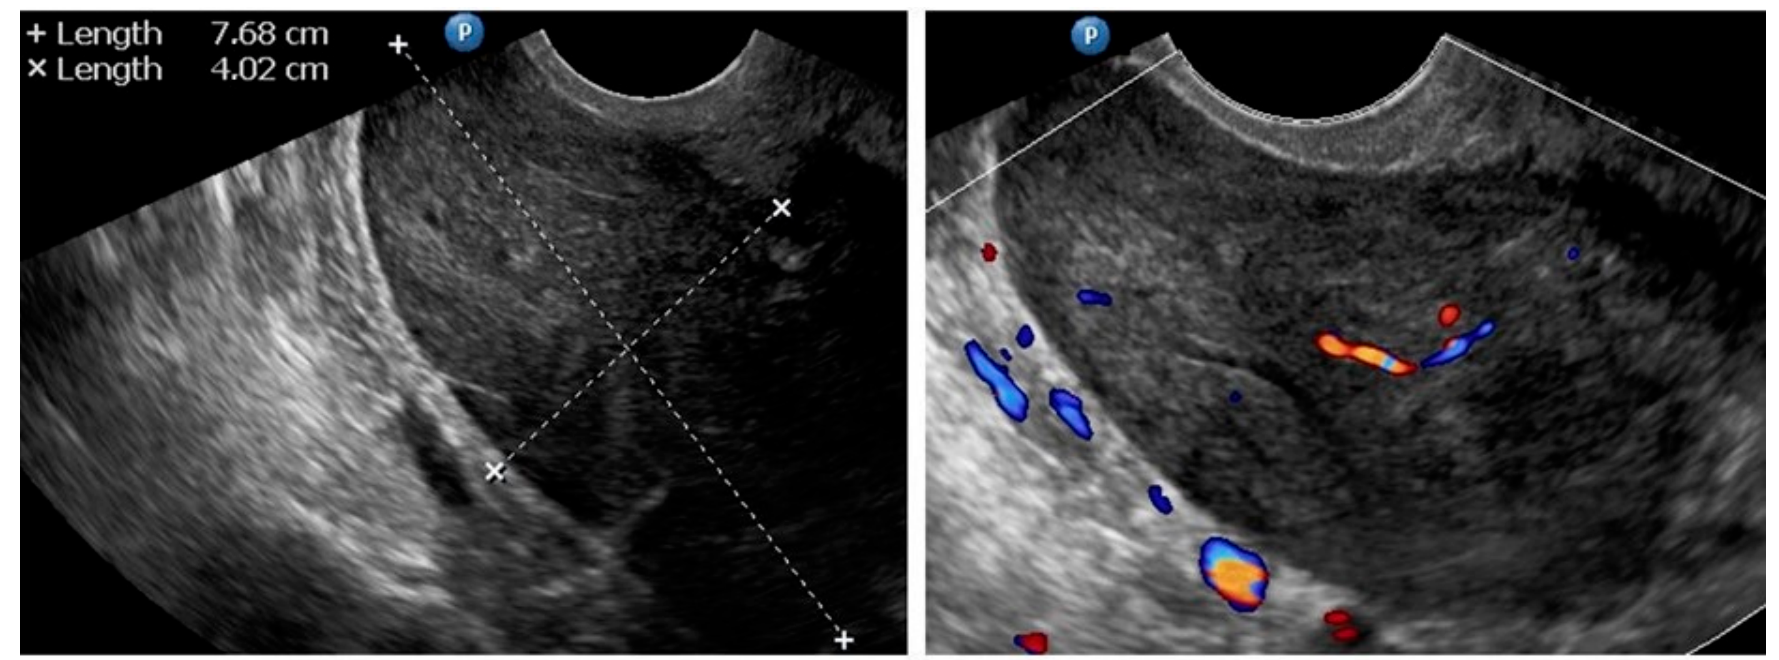
Figure A4. Transvaginal ultrasonogram of the uterine lesion (atypical) in subserosa myometrium, B mode and Doppler. Histology: leiomyoma.